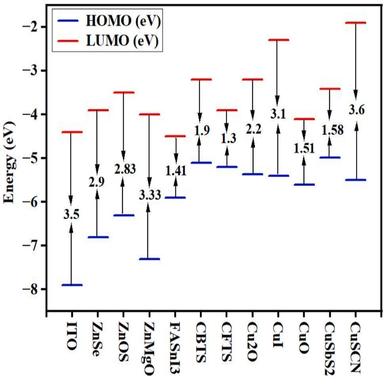
Energy level diagram of different layers showing HOMO-LUMO levels.